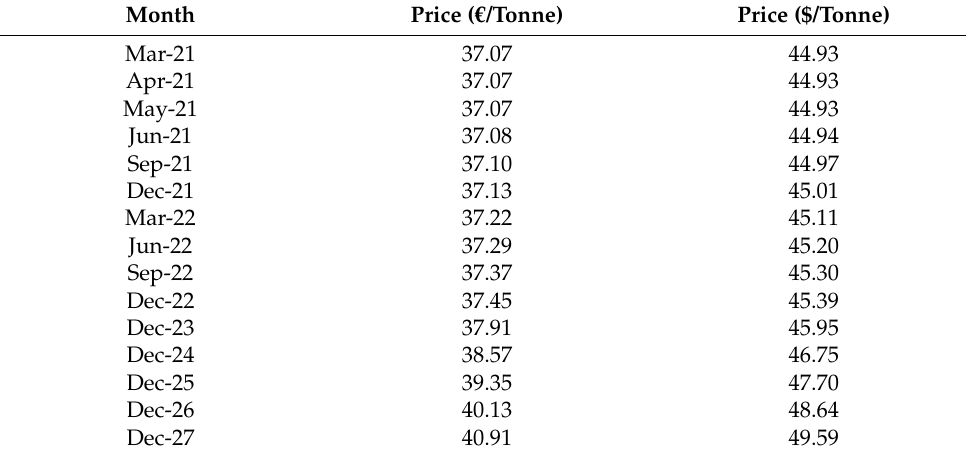
Figure 13. Optimal speed for selected vessels depending on the month. Table 9. Carbon emission futures